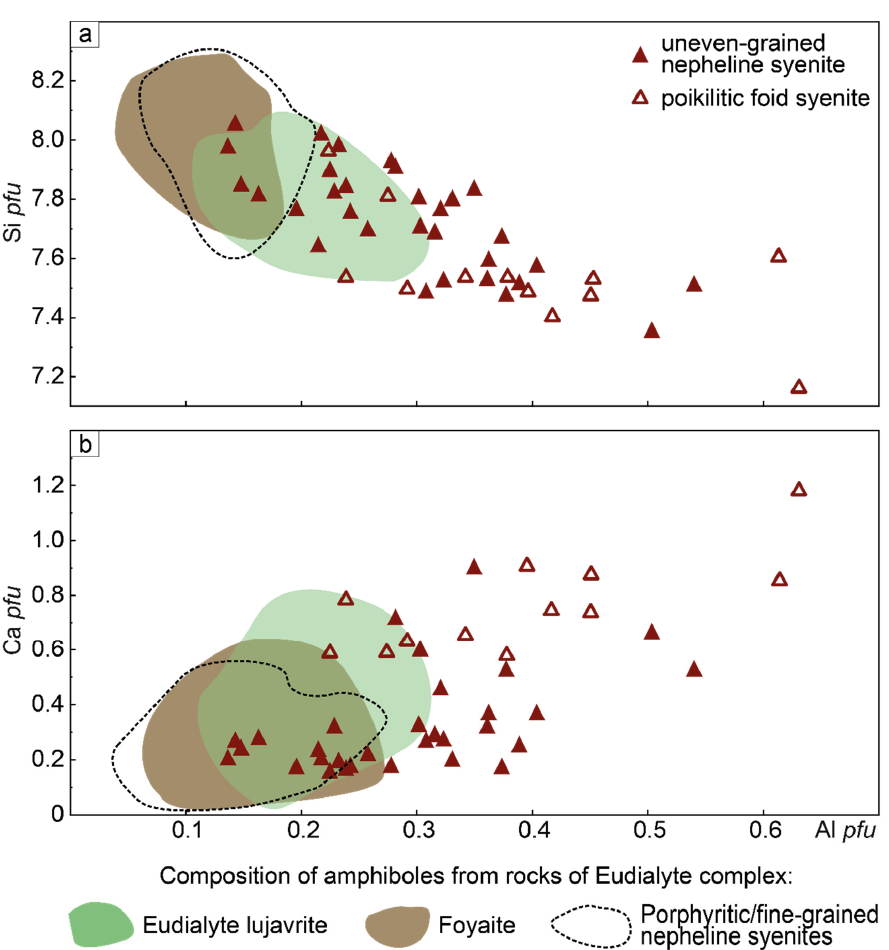
Figure 11. ( a ) Binary diagram showing the Si concentration in amphiboles from poikilitic rocks as function of Al content; ( b ) binary diagram showing the Ca concentration in amphiboles from poikilitic rocks as function of Al content. The compositions of amphiboles from the rocks of the Eudialyte complex (adapted from [54]) are denoted by colored backgrounds and a dashed line.